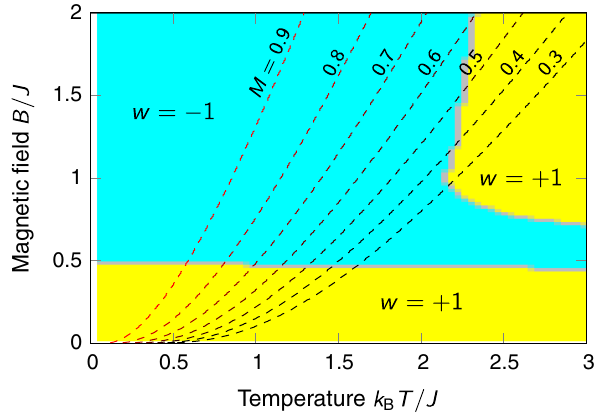
FIG. 14. Interaction-induced magnonic topological phase dia- gram of the chiral honeycomb ferromagnet in Fig. 1(b) as extracted from the effective model Hamiltonian (33); S ¼ 1 and D=J ¼ 0 . 15 . Both a change in magnetic field B and in temperature T causes topological phase transitions. Dashed lines indicate the relative magnetization M [see Eq. (43); note M ð T ¼ 0 Þ ¼ 1 ], as evaluated within linear spin-wave